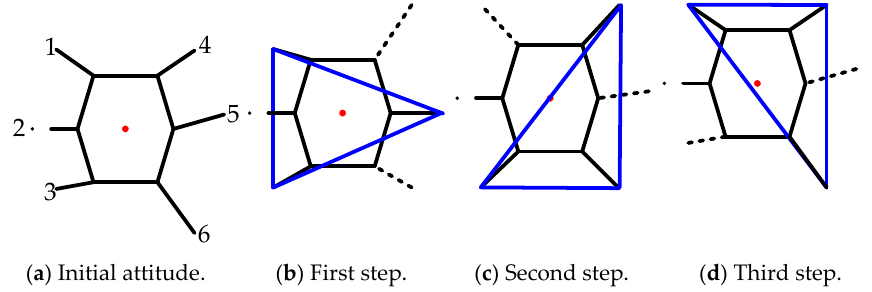
Figure 12. F-TT gait locomotion with coxa initialization angle adjustment in leg 1 fault state.